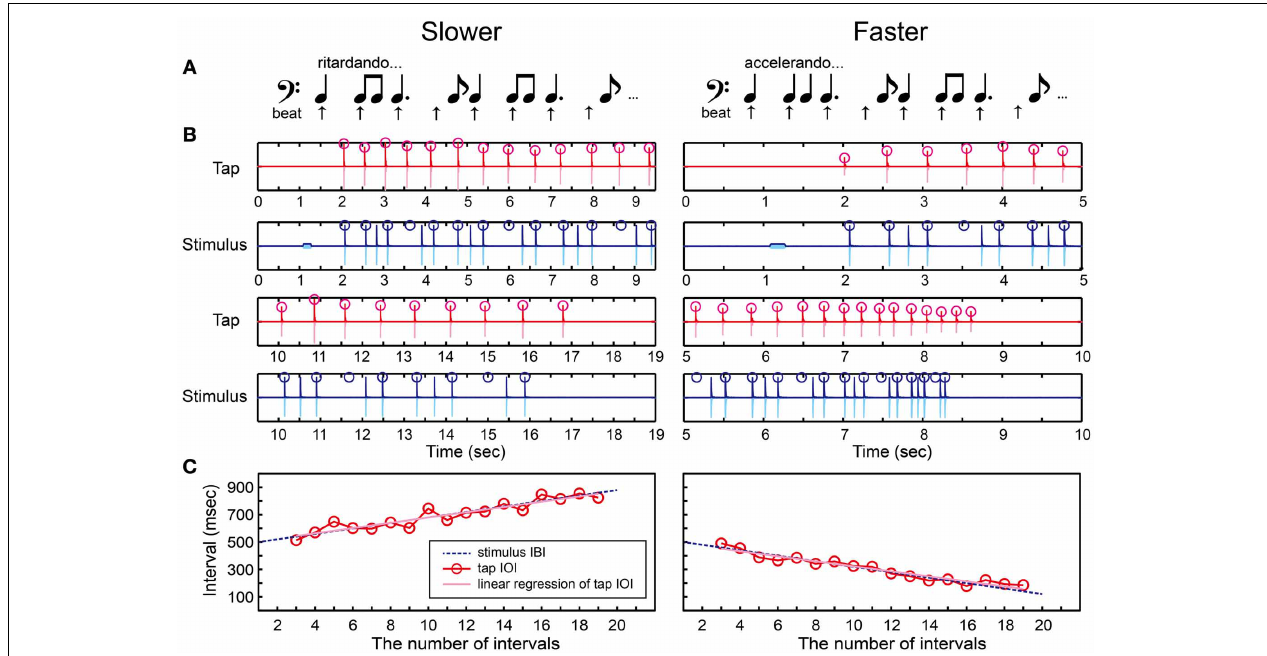
FIGURE 7 | Beat finding and interval test (BFIT). (A) A rhythmic pattern was created by repeating a quarter note, two eighth notes, a dotted-quarter note, and an eighth note. The beat underlying the pattern (upper arrows) slows down (ritardando, slower) or speeds up (accelerando, faster). (B) An example of recorded tap signal (pink), its envelope (red), recorded auditory stimulus (light blue), and its envelope (blue). Red circles represent the detected tap onsets and